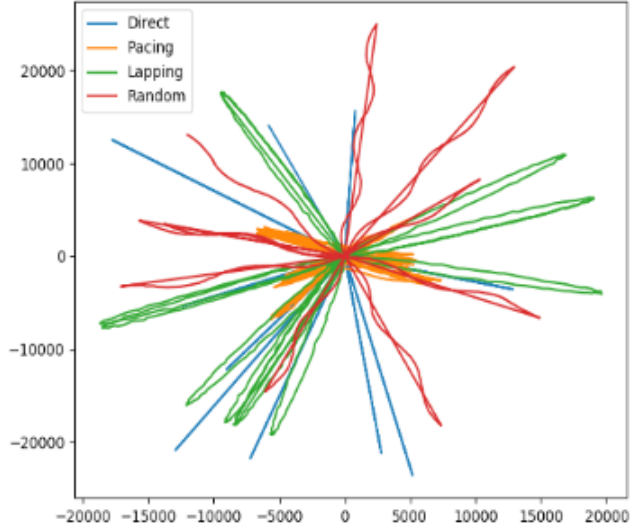
Figure 4. Simulate data of direct, pacing, lapping and random.